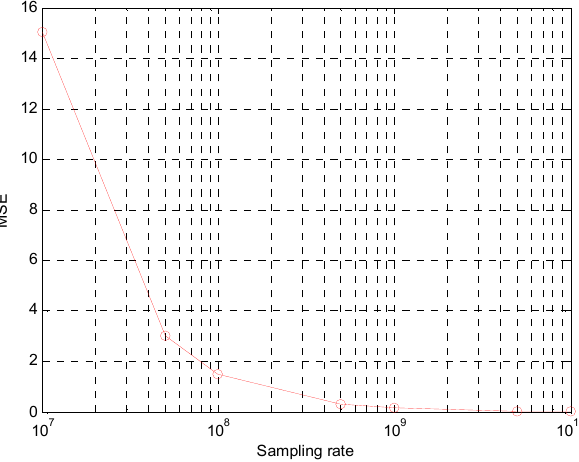
Figure 8. MSE of distances between MS and BSs for the third case.